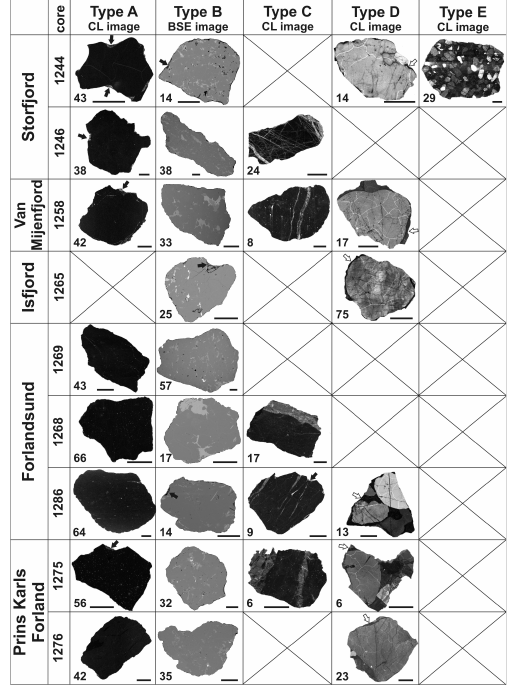
Fig. 4. Classification of quartz grains of the >500µm size fraction according to their CL characteristics and micro-inclusion contents. Representative CL images of type A, C, D and E grains and BSE images of type B grains are shown. The numbers in the lower left of each cell indicate the percentage on the total number of quartz grains found. The scale bar length corresponds to 200µm. The black arrows indicate remains of sericite cement at quartz grain edges and the white arrows remains of authigenic quartz. Table 3. Suggested primary and secondary rock type origin of quartz grains in the >500µm fraction of investigated offshore samples. Grain